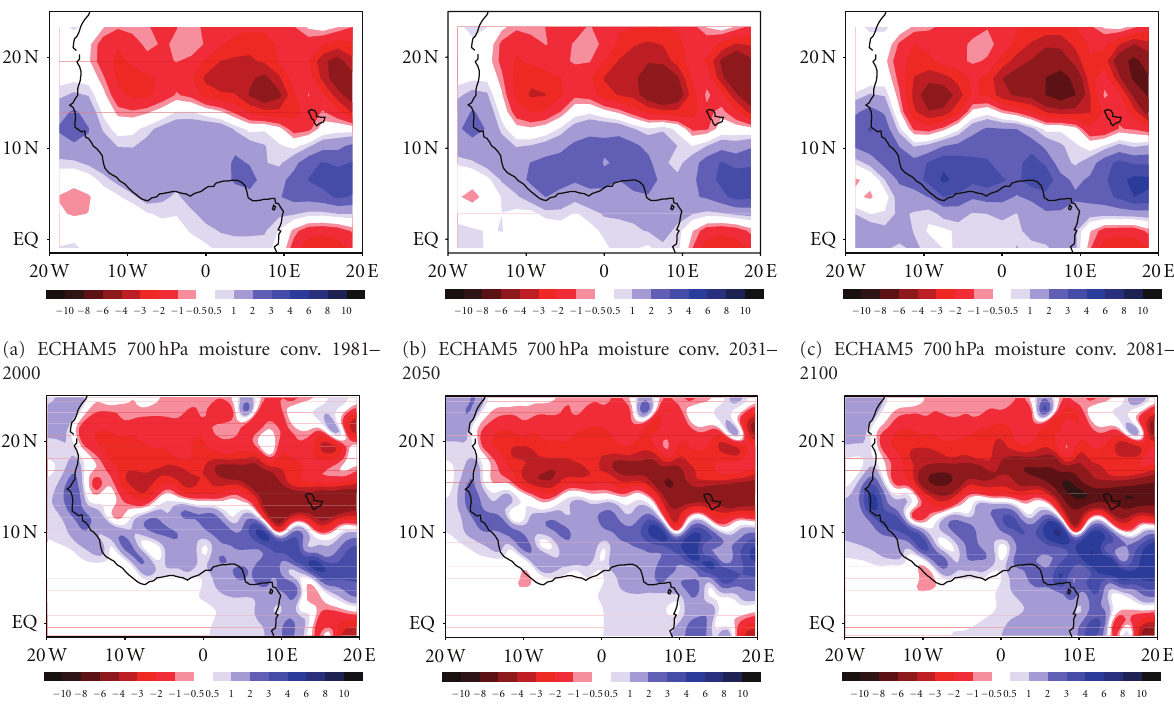
Figure 12: Mean summer (June–August) low-level moisture flux convergence from ECHAM5 (upper) and RegCM3 (lower) during the present day (left), the early (middle), and the late (right) 21st century. Units are expressed as s − 1 . Positive shades represent convergence, while negative shades define